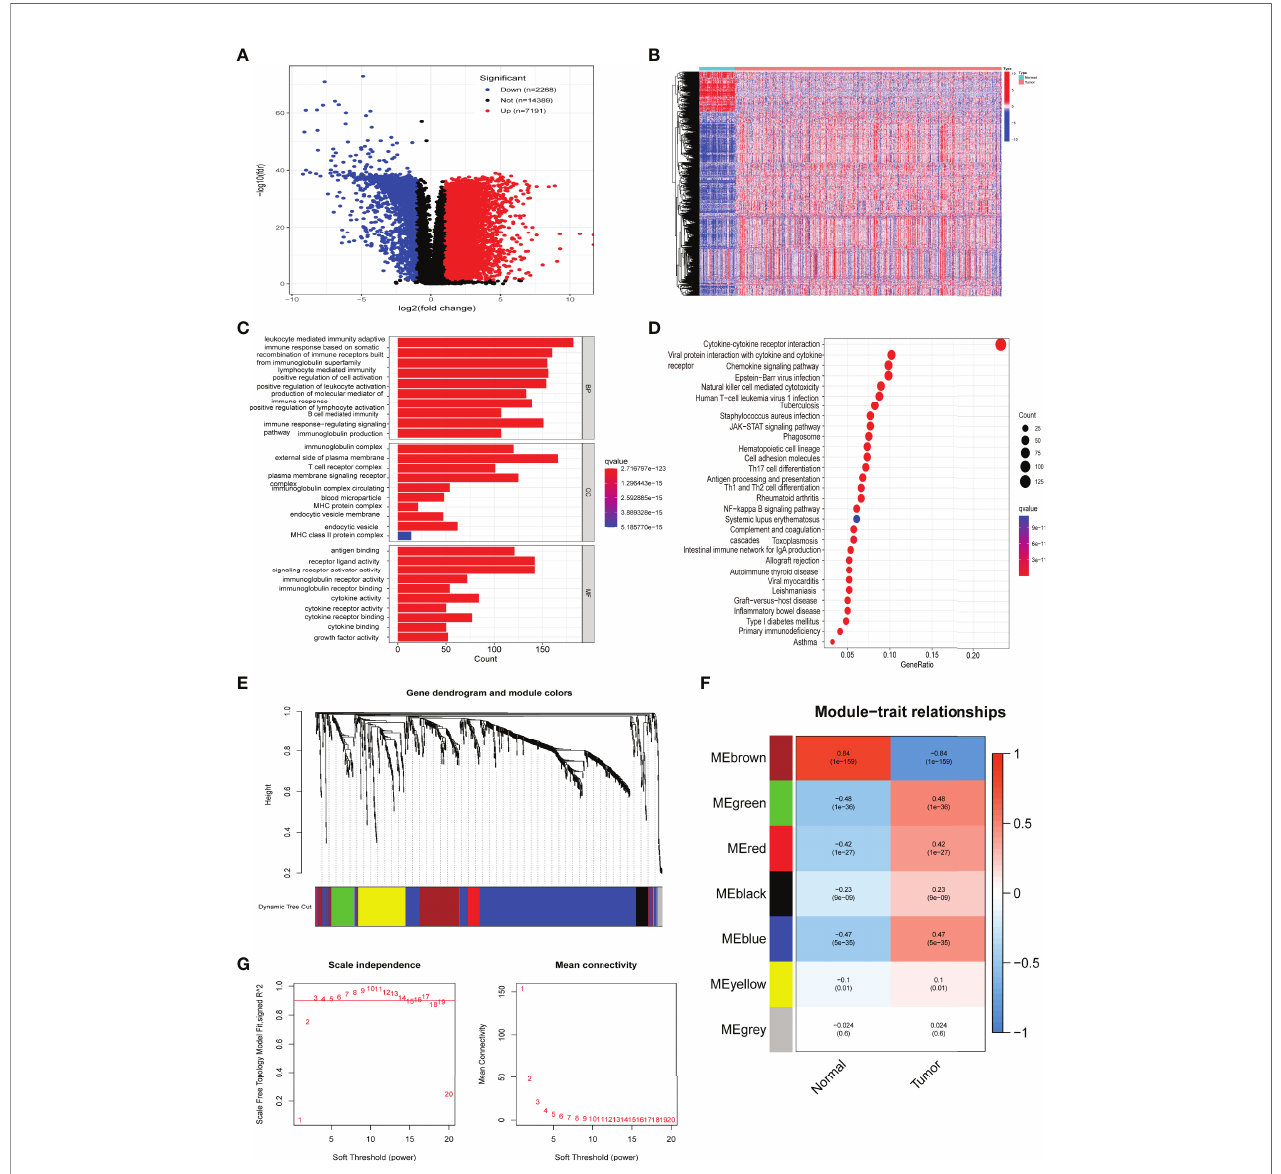
FIGURE 2 | Screening and functional enrichment analysis of immune-related differentially expressed genes (DEGs), with identi fi cation of hub genes. (A) Volcano plot of ccRCC differentially expressed genes. (B) Heatmap of immune-related DEGs. (C) Gene Ontology (GO) enrichment analysis of immune-related DEGs. (D) Kyoto Encyclopedia of Genes and Genomes (KEGG) pathway analysis of immune-related DEGs. (E) Gene dendrograms and color distribution were obtained from WGCNA. (F) Gene modules with different survival relevance were obtained by WGCNA. (G) Determination of the optimal soft threshold in